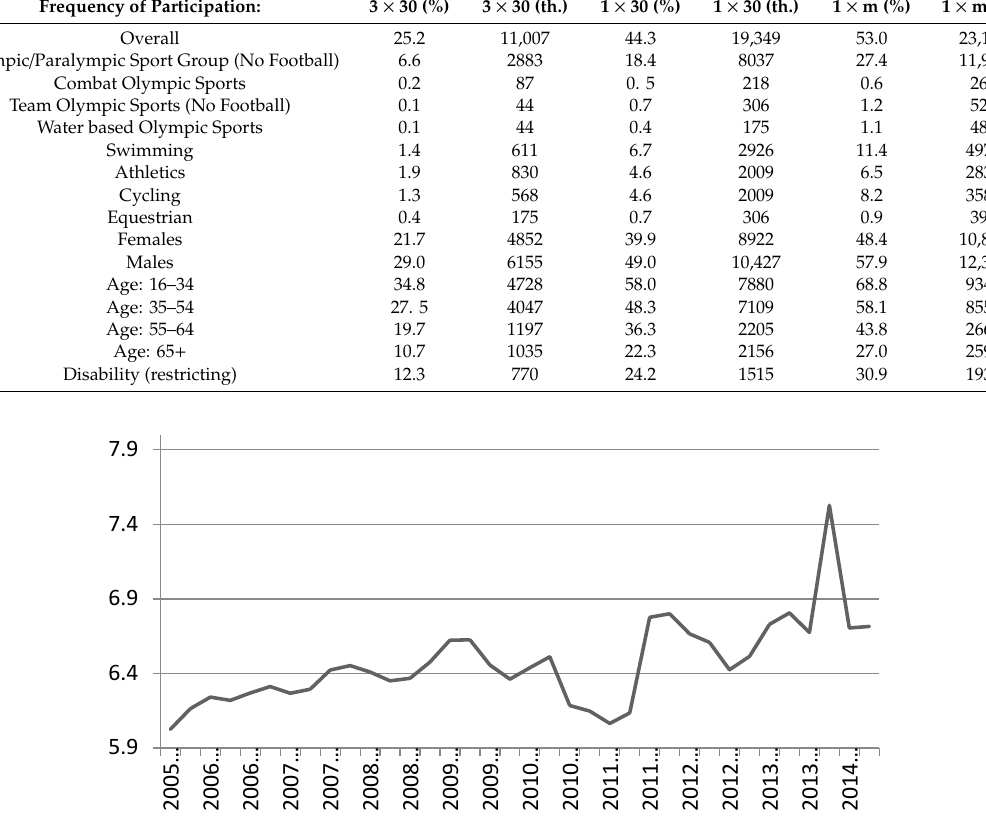
Figure 1. Olympic sport rates, 3 × 30 definition, seasonally adjusted participation.